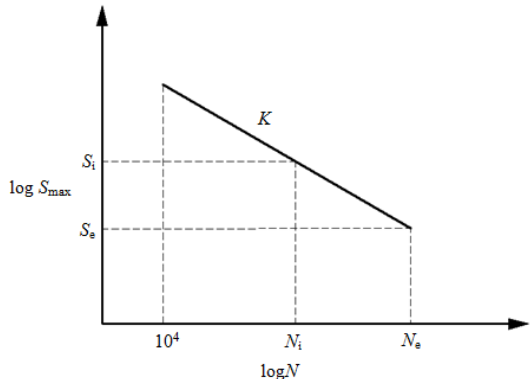
Figure 2. Ideal S-N curve.